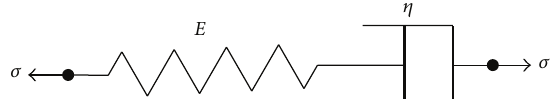
Figure 1: Maxwell model is made of springs ( 𝐸 ) and dashpots ( 𝜂 ) in series, and the forces acting on two parts are